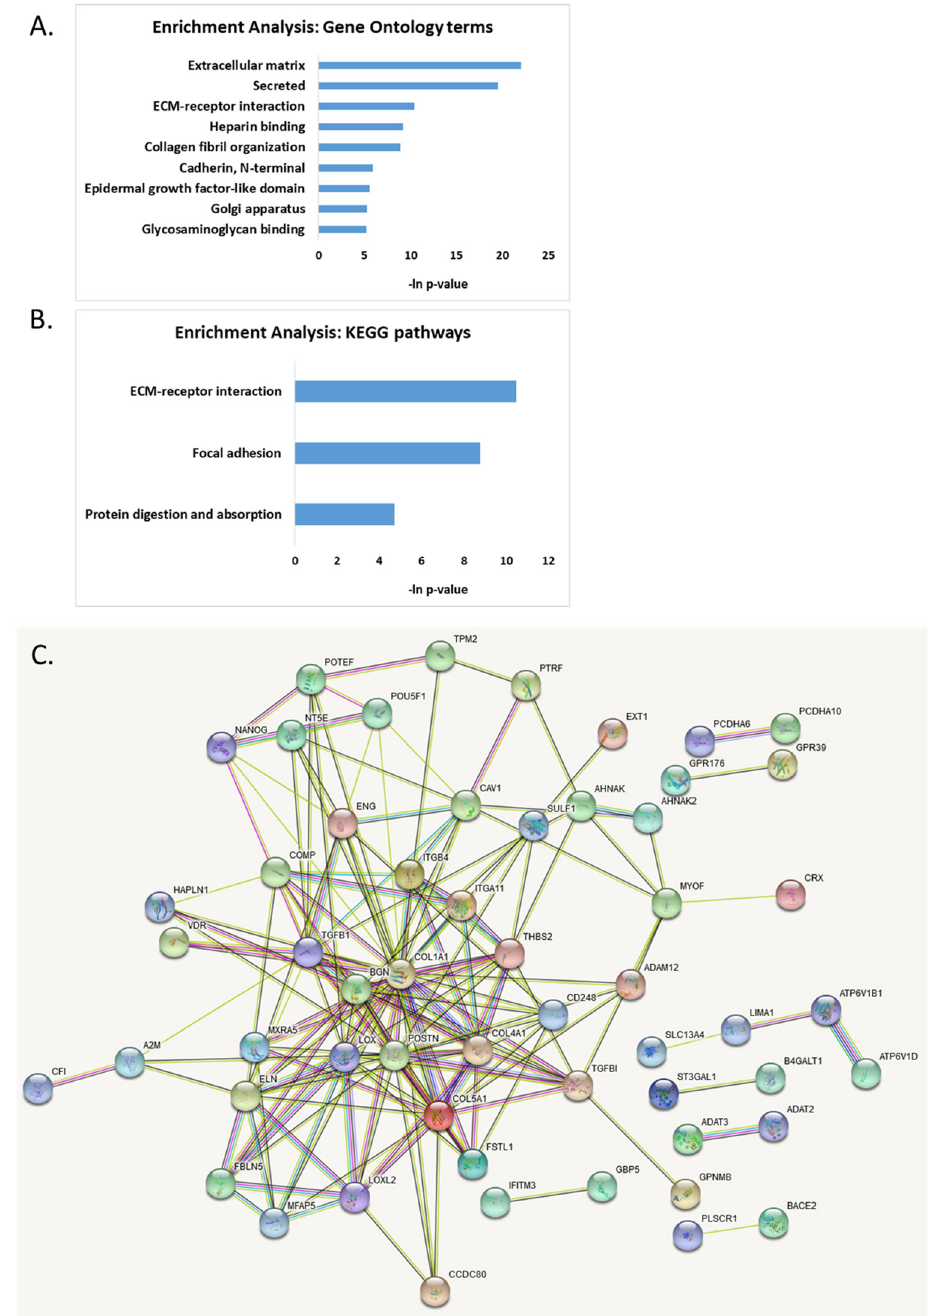
Figure 6. Functional enrichment analysis of genes found to be dysregulated both on DNA methylation level and on gene expression level. ( A ) Gene ontology enrichment analysis; ( B ) KEGG pathways enrichment analysis; ( C ) protein–protein interaction map generated with STRING tool.